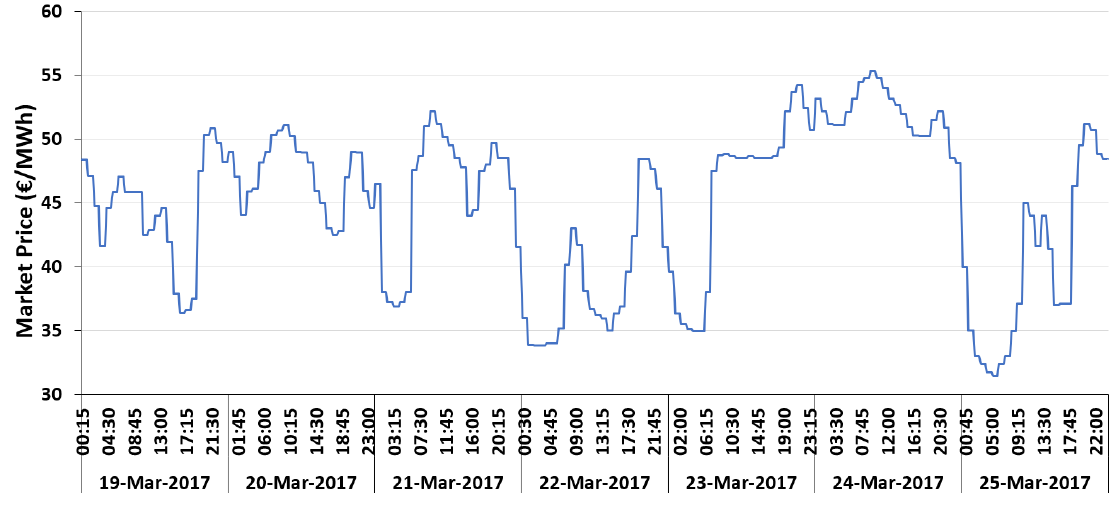
Figure 10. Market